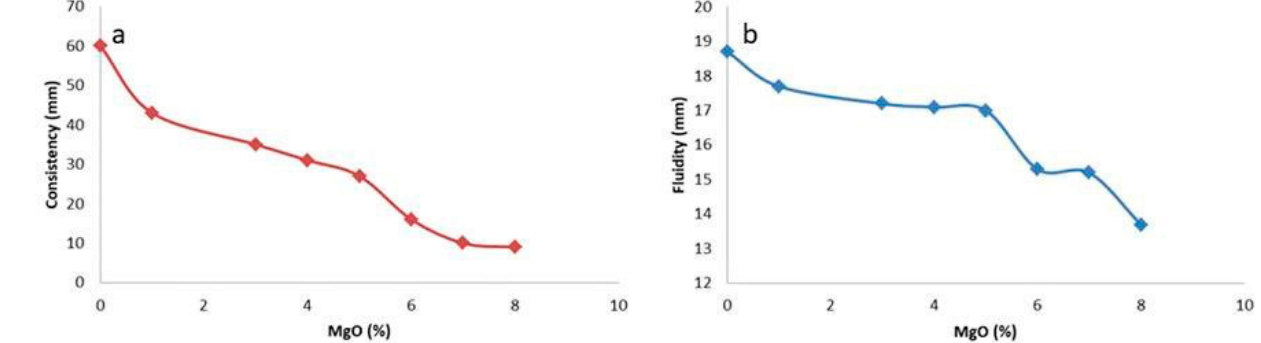
Figure 9. Influence of MgO on the ( a ) consistency and ( b ) fluidity of cement.